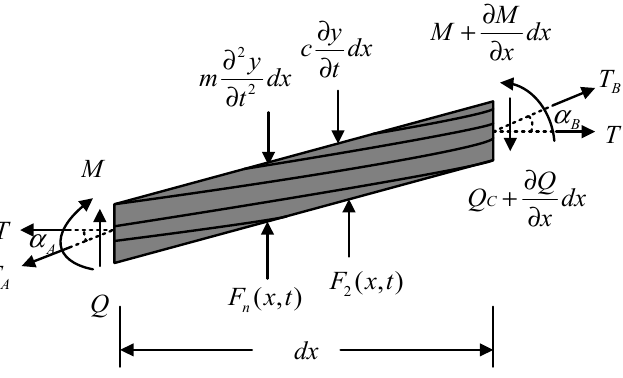
Figure 5. Transmission line element diagram.